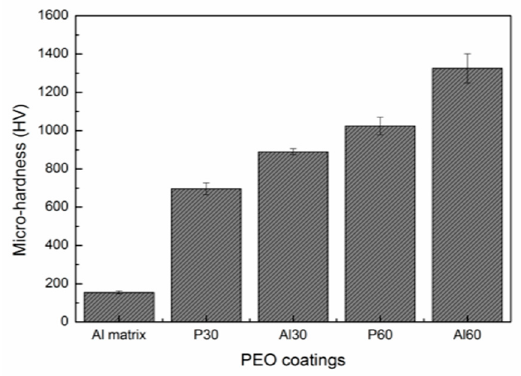
Figure 6. Micro-hardness of 6061 Al alloy substrate and PEO coatings.